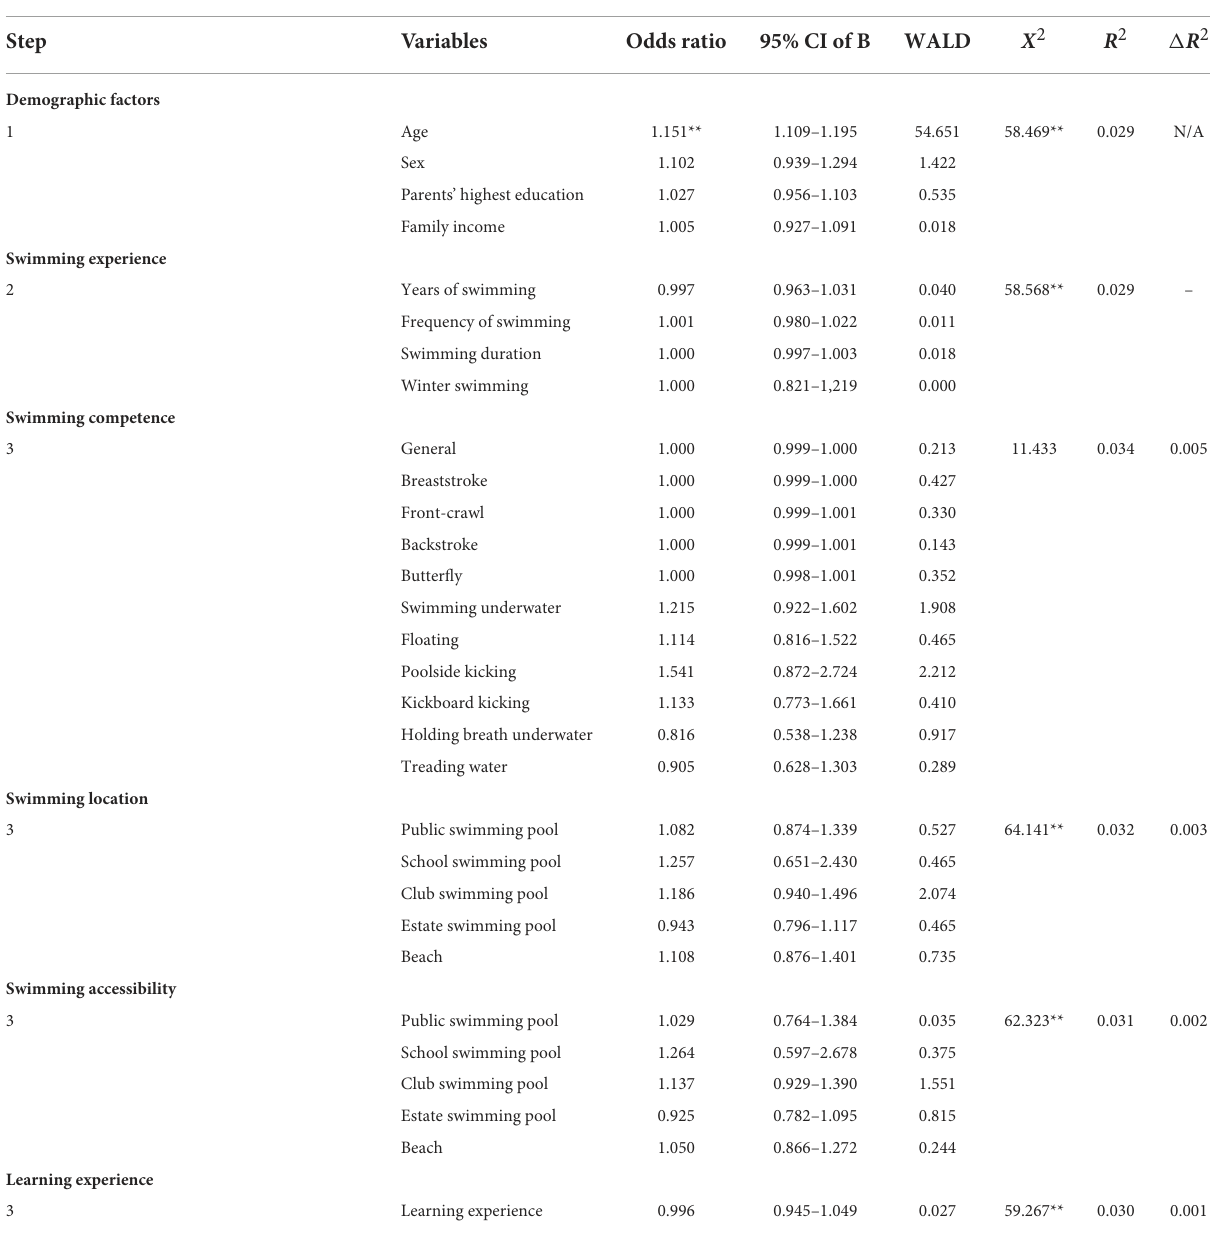
TABLE 5 Results of hierarchical logistic regression